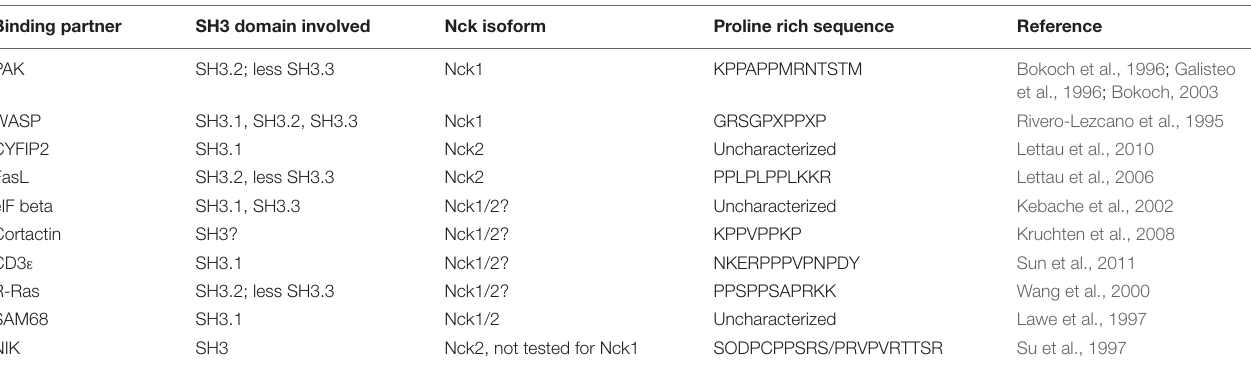
TABLE 2 | Some of the known Nck1/2 SH3 binding